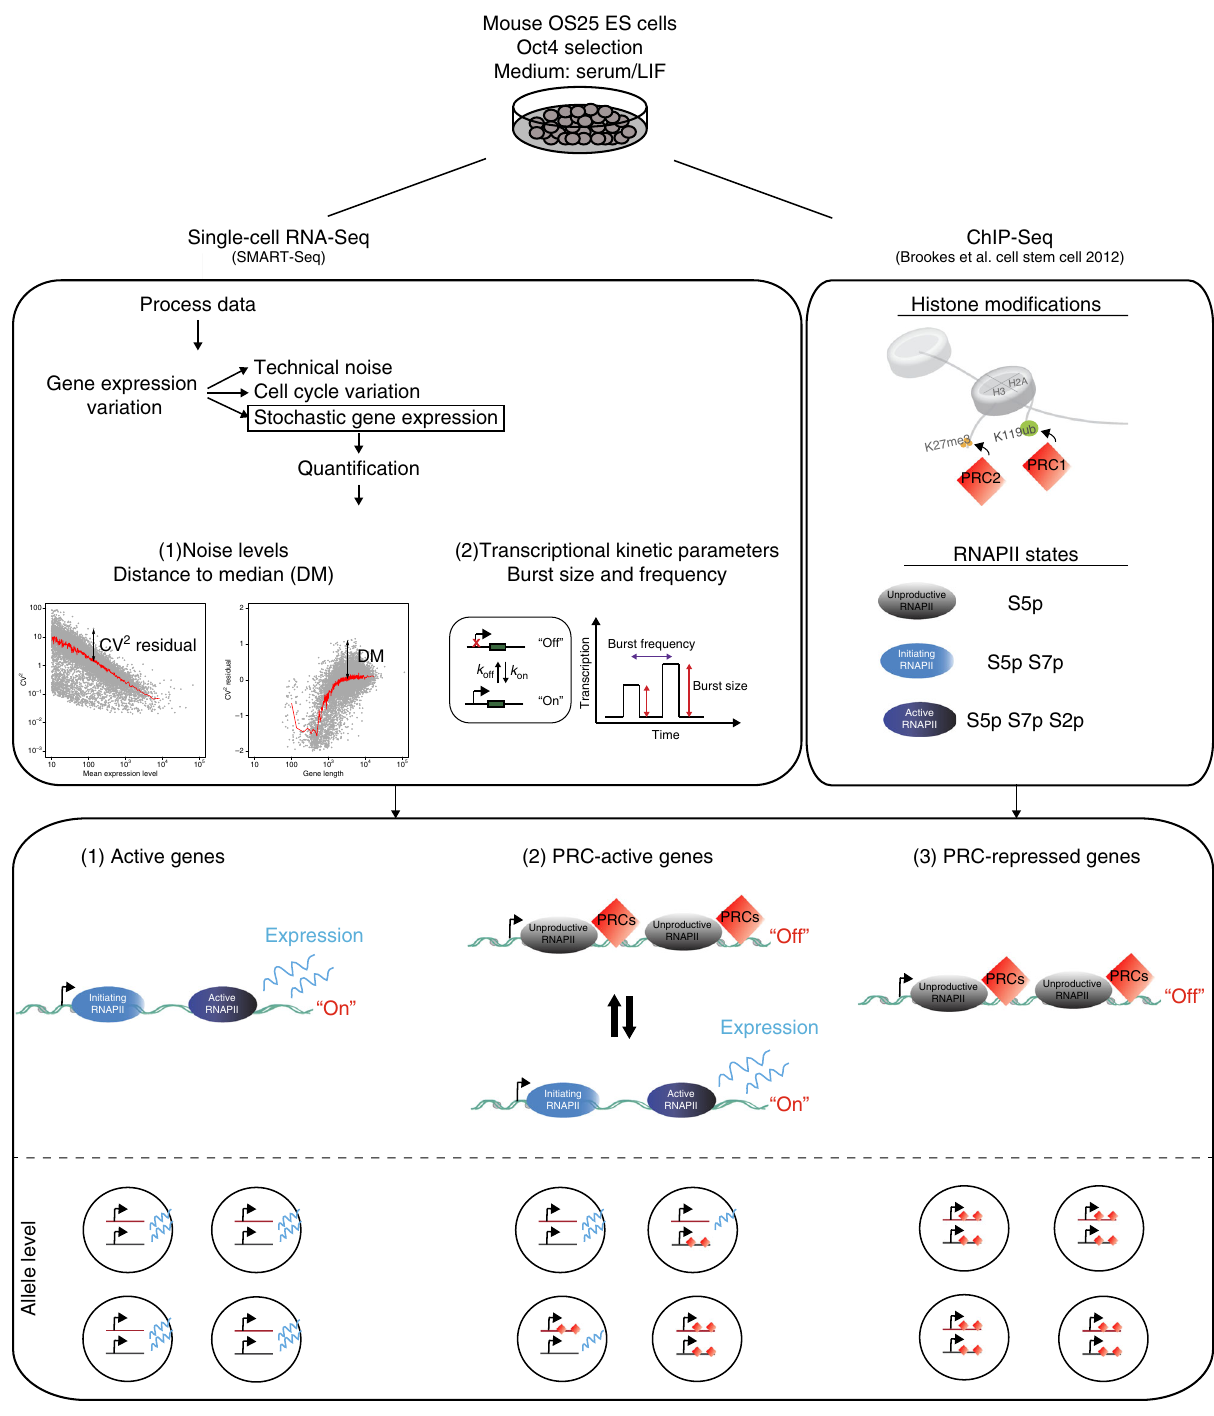
Fig. 1 Summary of methodology. OS25 mESCs were cultured and characterized by single-cell RNA-seq using the Fluidigm C1 system, applying the SMARTer kit to obtain cDNA and the Nextera XT kit for Illumina library preparation. OS25 cells are grown in conditions that select for undifferentiated cells (high Oct4 -expressing). Libraries from 96 cells were pooled and sequenced on four lanes of a HiSeq. After quality-control analysis of cells, 90 cells out of 96 remained for further analysis. We fi rst unraveled contributions of components of gene expression variation using the scLVM method 13 . Removing cell cycle variation and technical noise allowed us to focus on stochastic gene expression. Gene expression variation can be quanti fi ed by CV 2 or DM, which is a measure of noise independent of gene expression levels and gene length. To explore the transcriptional kinetics of OS25 ES cells, poisson-beta model 16 was fi tted to single-cell gene expression data, leading to estimates of burst frequency and size. Next, histone and RNAPII promoter modi fi cations were obtained from Brookes et al. 5 and integrated with single-cell RNA-seq to investigate relationship between stochastic gene expression and epigenetics. Active genes with no PRC marks are usually in the “ on ” state with high burst frequencies ( k on ), PRCr genes are mostly “ off ” and PRC-active genes switch between “ on ” and “ off ” states very frequently. Considering the allele-level possibilities, at active genes, both alleles would be in an actively transcribing state. For PRCa genes, both alleles would be in an actively transcribing state, or both alleles would be in a silent PRC-marked state, or only one allele is in PRC-marked state, which, subsequently, would result in noisier gene expression. For PRC-repressed genes, both alleles are expected to be in a silent PRC-marked